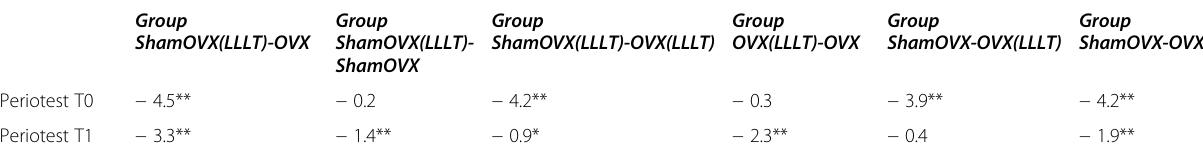
OVX were lower than those in group shamOVX. The cause